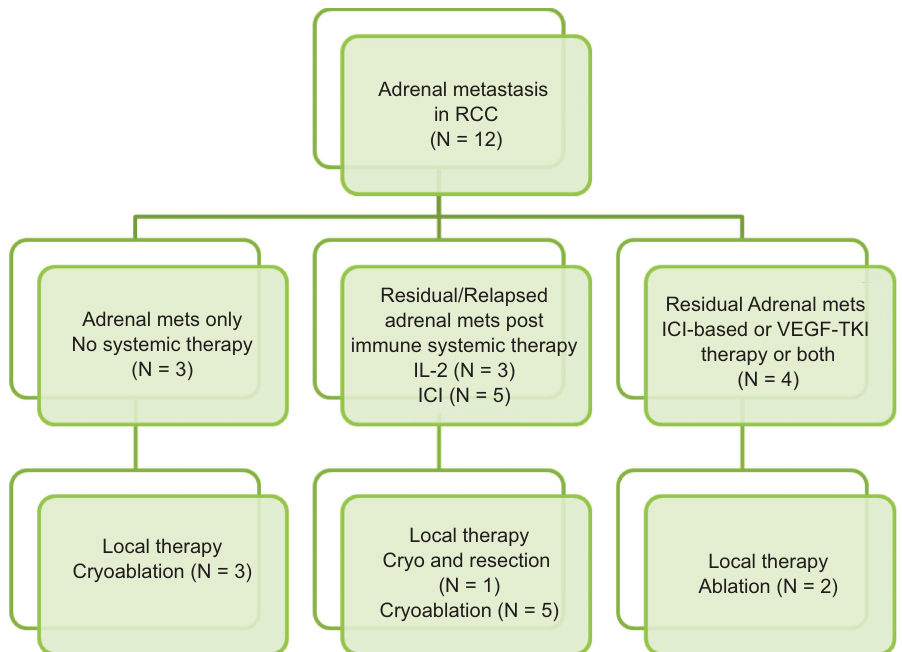
Figure 3: Management flow chart for adrenal metastases in renal cancer. Overlap is seen as some patients received multiple dif- ferent types of